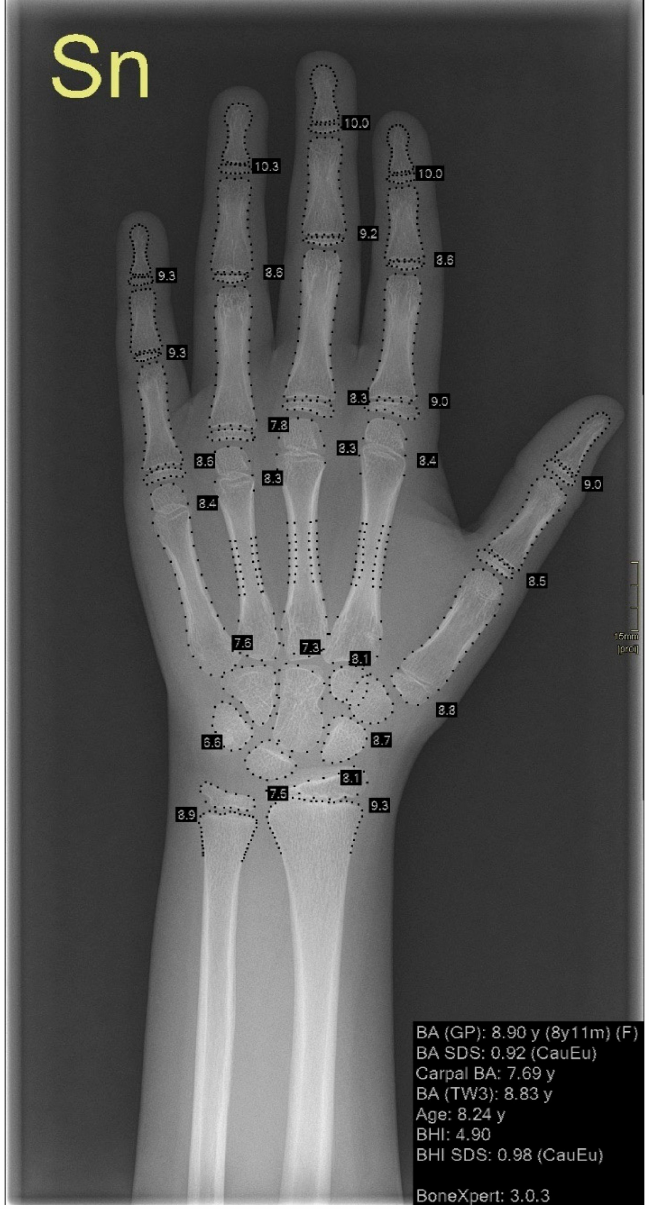
Figure 3. Example of an X-ray analyzed with BoneXpert. Standard radiograph of left hand and wrist. BoneXpert automatically recognizes bone segments and analyzes the hand–wrist bones. The analysis results are shown in the black box on the right, where bone age is calculated through both GP and TW3